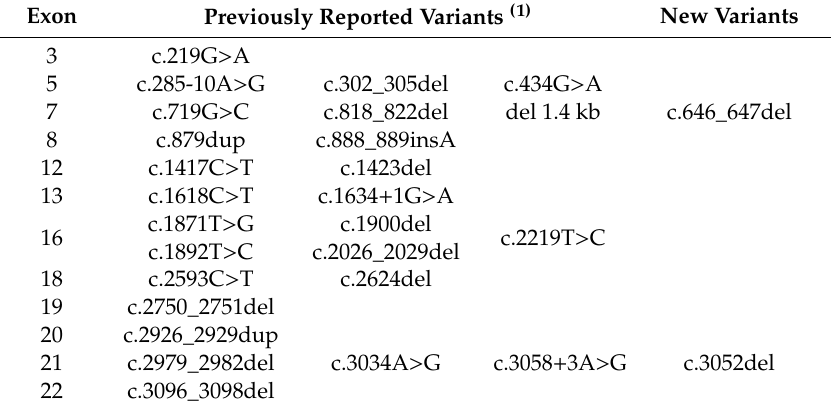
Table 2. Variants have been identified in the human HPS5